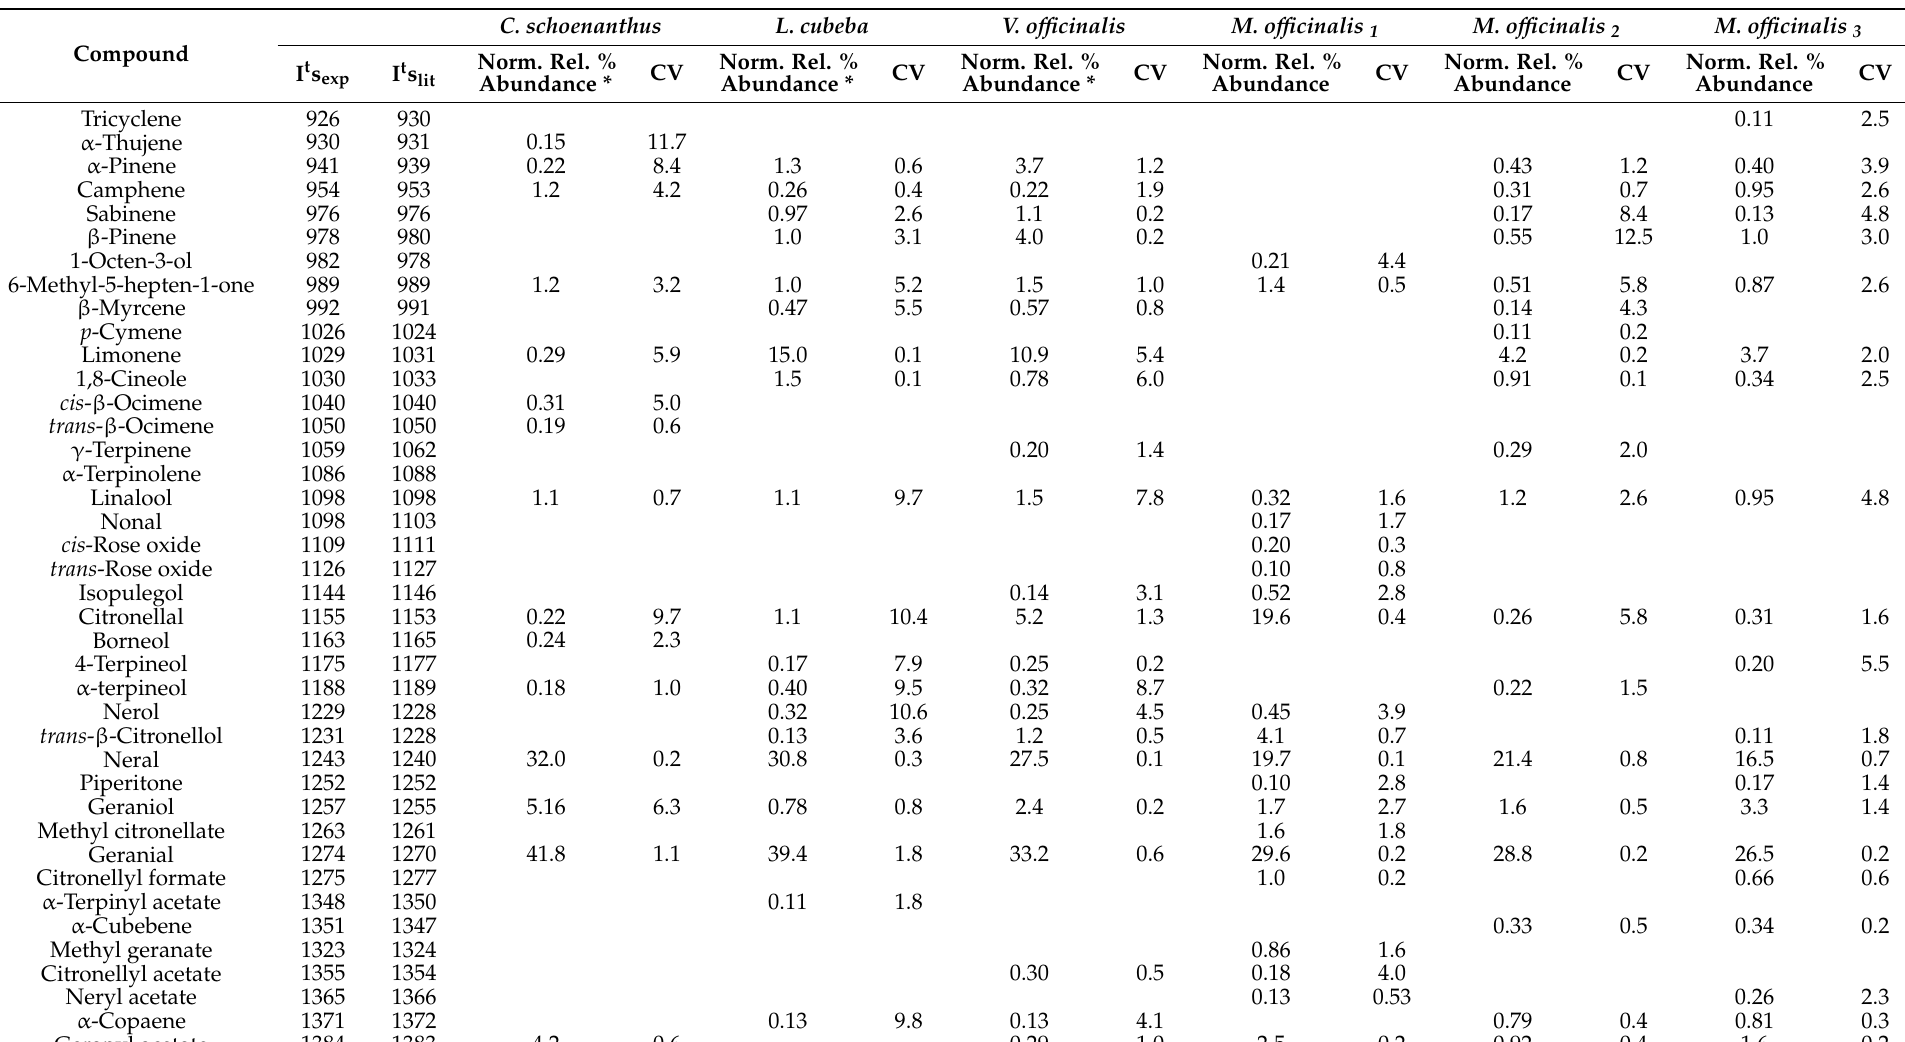
Table 1. Normalized percentage abundance of the compounds identified in the essential oils under investigation. For complete compositions, see Supplementary Materials Table S1–S5.